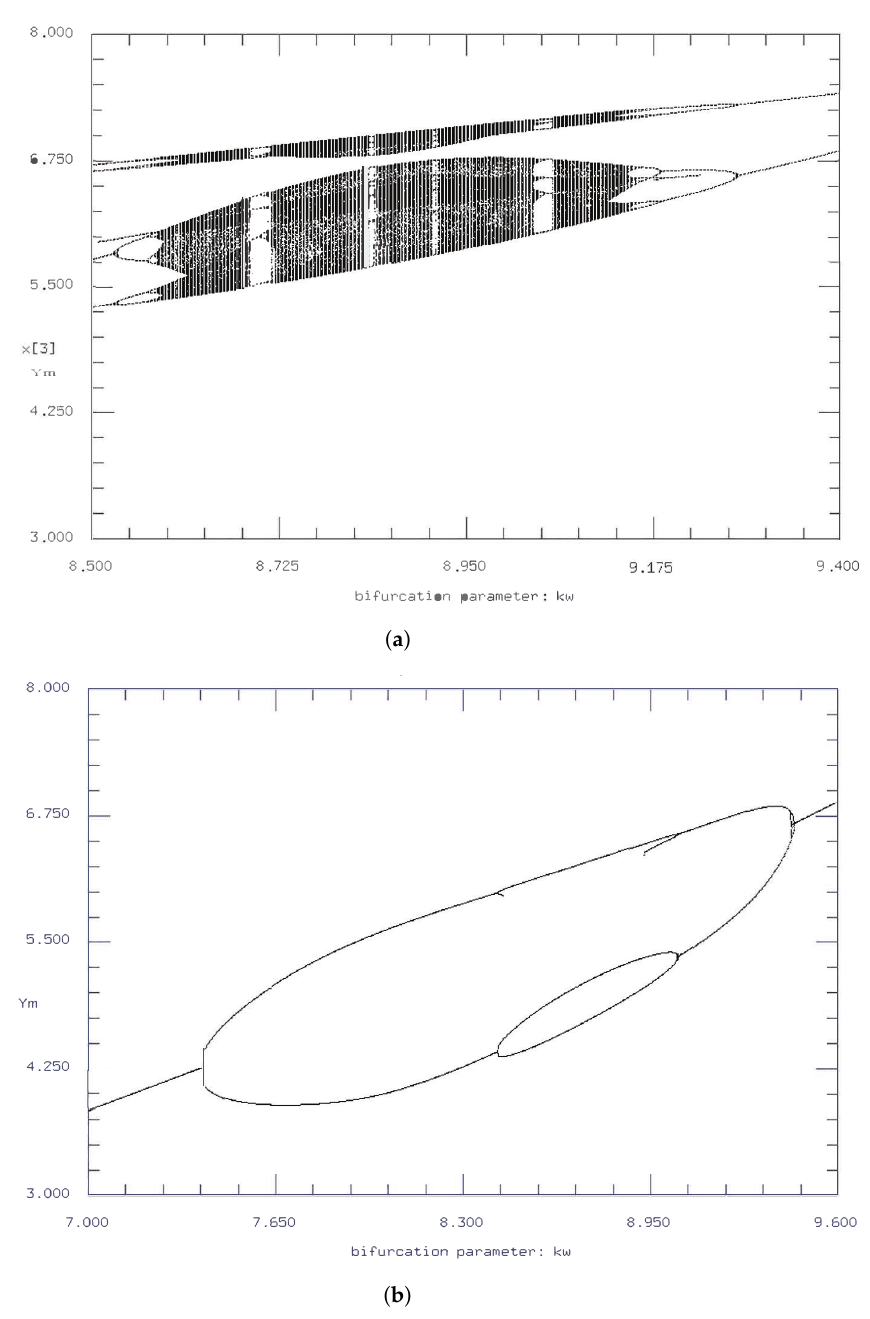
Figure 12. Bifurcation diagrams of k w for Y m with ( a ) k f = 0.005, and ( b ) k f = 0.010 and other parameters from Table